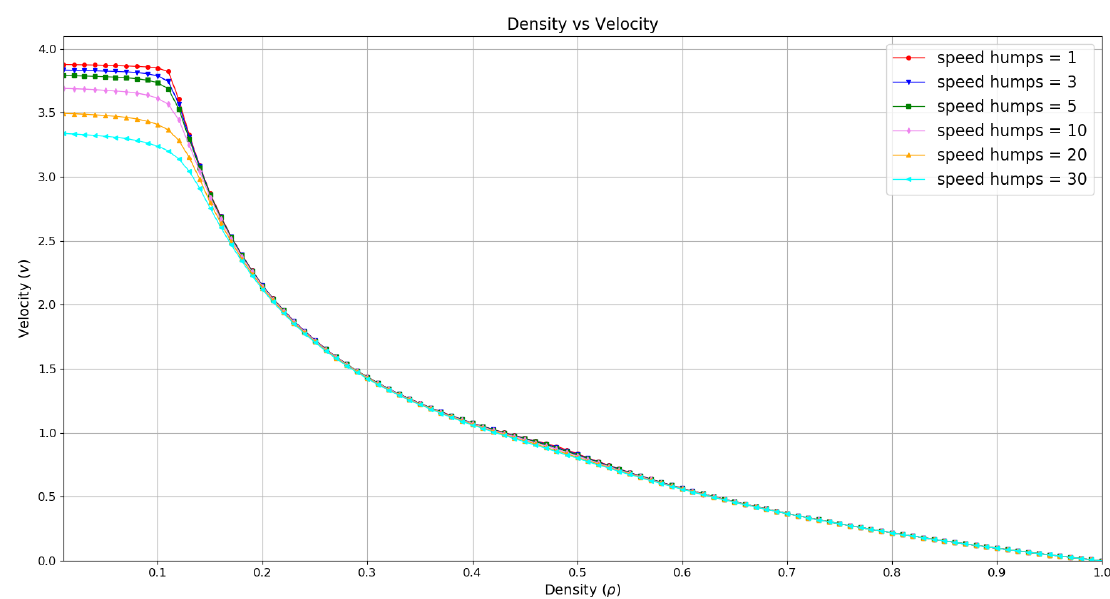
Figure 3. Average velocity as a function of density. The velocity indicates the average number of cells to move forward per simulation step, and the density ρ = N / L